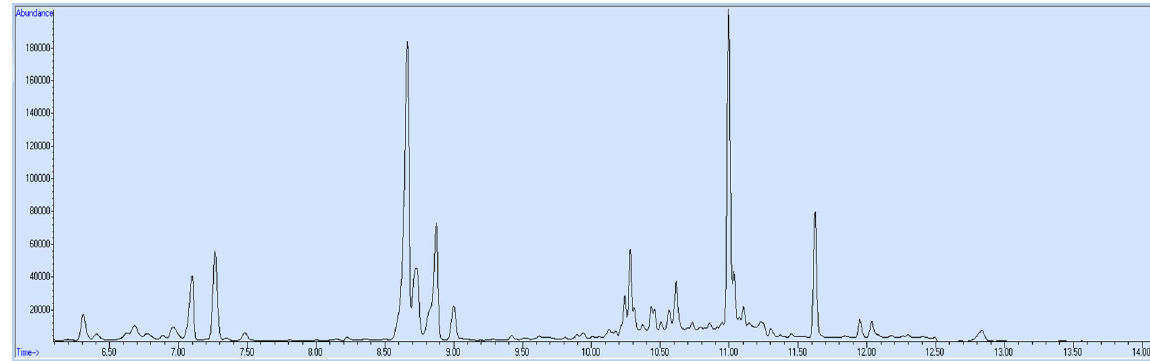
Figure 2. Blood sample—ion chromatogram.